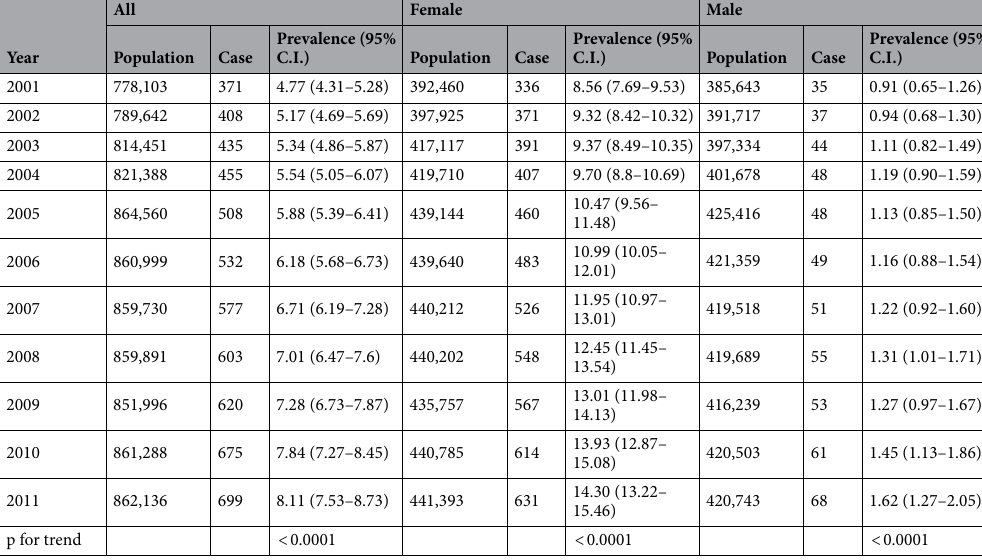
Table 1. Prevalence (per 10 4 people) of SLE among 10–79 years old people in Taiwan from 2001 to